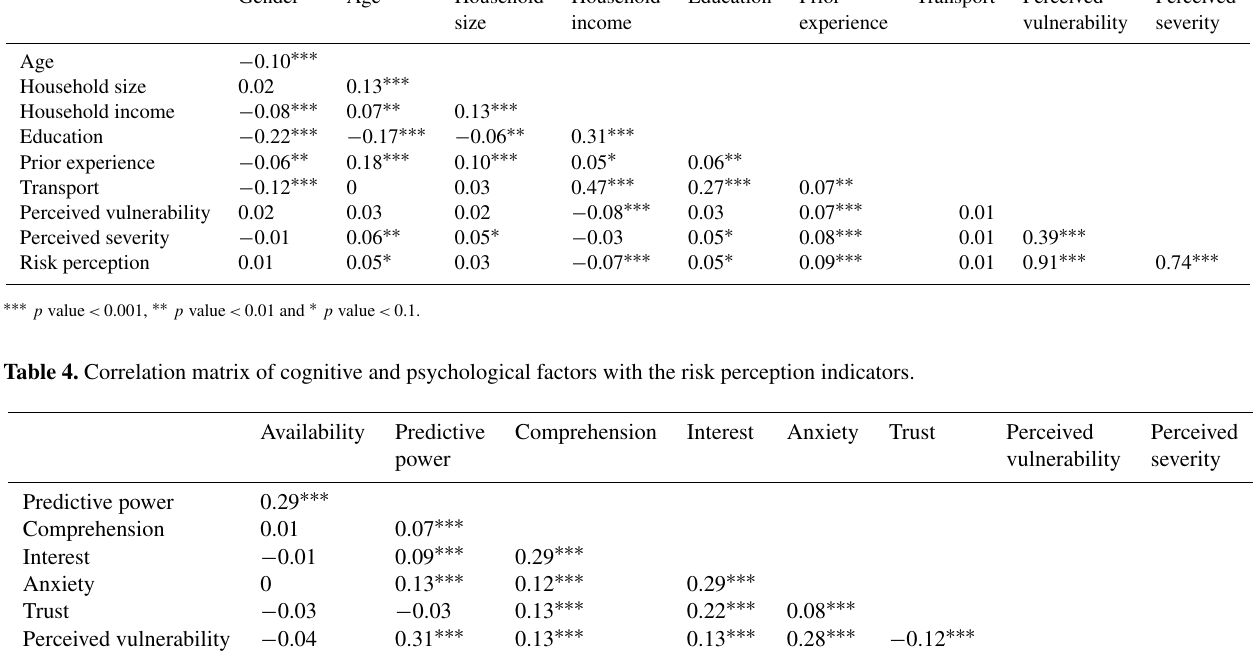
Table 3. Correlation matrix of demographic and contextual factors with the risk perception indicators. Gender